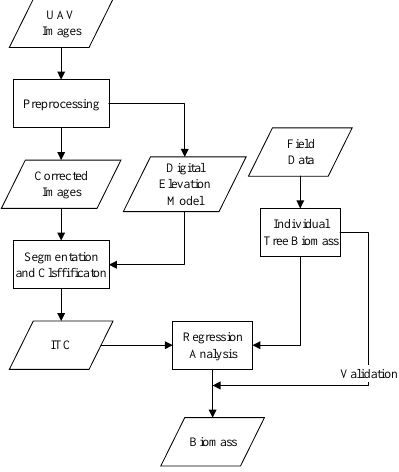
Figure 2. Methodological